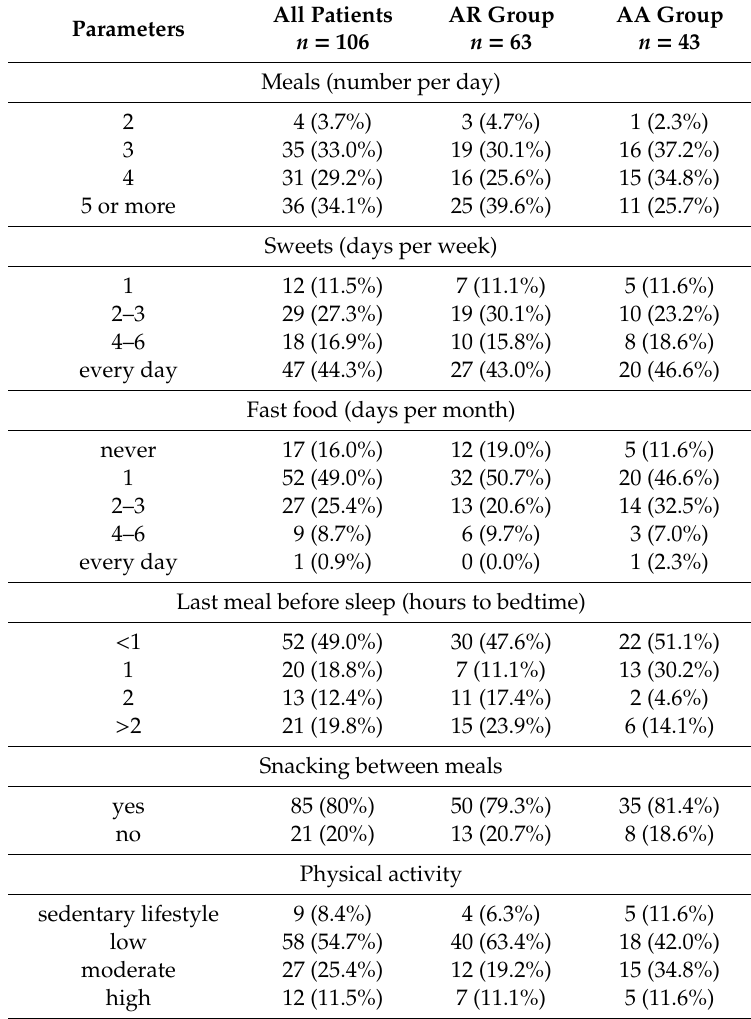
Table 2. Eating habits and physical activity